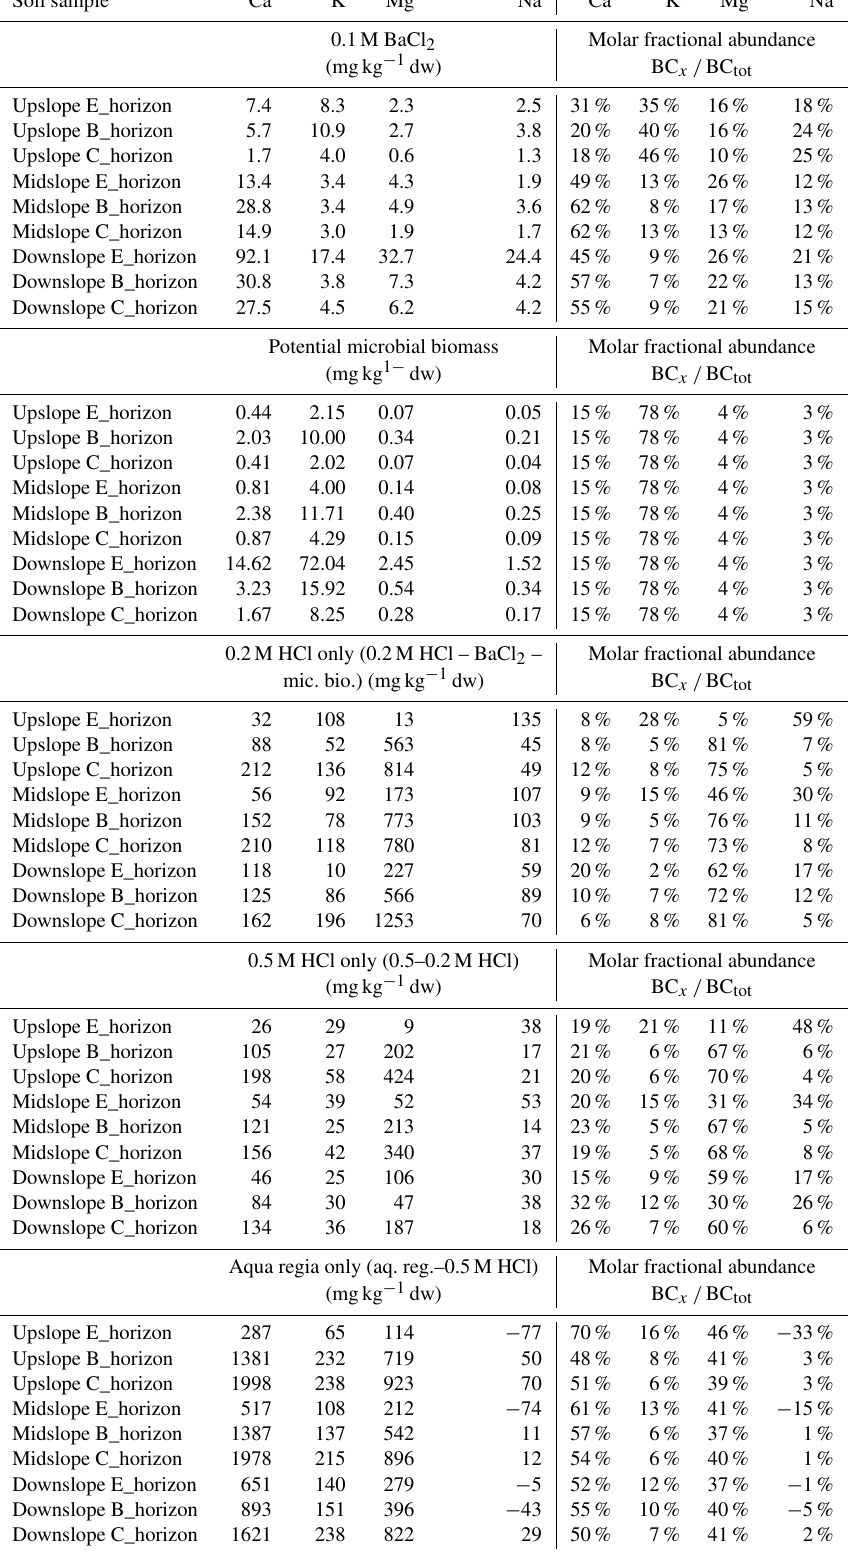
Table 4. Mineral soil base cation concentrations from different soil fractions as defined by extractant and relative molar fraction of each base cation within each